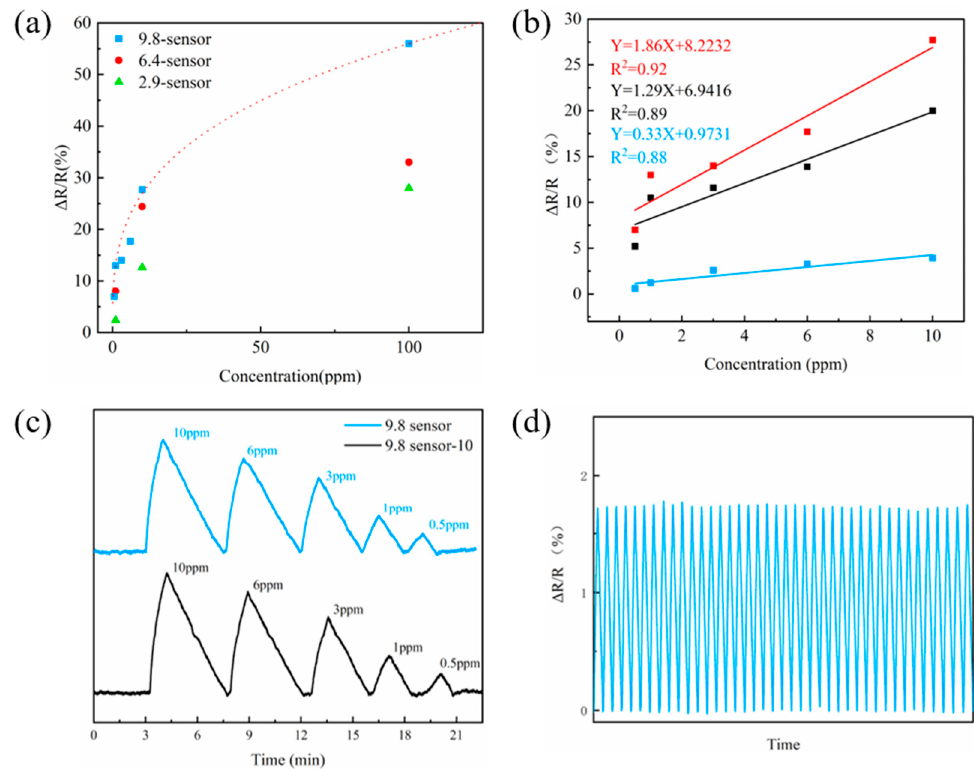
Figure 5. ( a ) Responsivity vs. concentration plot of the three sensors exposed to different concentra- tions of NO 2 . ( b ) Sensitivity of the 9.8-sensor (red line), 9.8-sensor after 30 bending (black line), and 9.8-sensor-upon-quick-cycling (blue line) exposed to 0.5–10 ppm NO 2 . ( c ) Sensing performance of 9.8-sensor and 9.8-sensor-10 exposed to different concentrations of NO 2 . ( d ) Cycling performance of 9.8-sensor-10 in 1 ppm NO 2 .